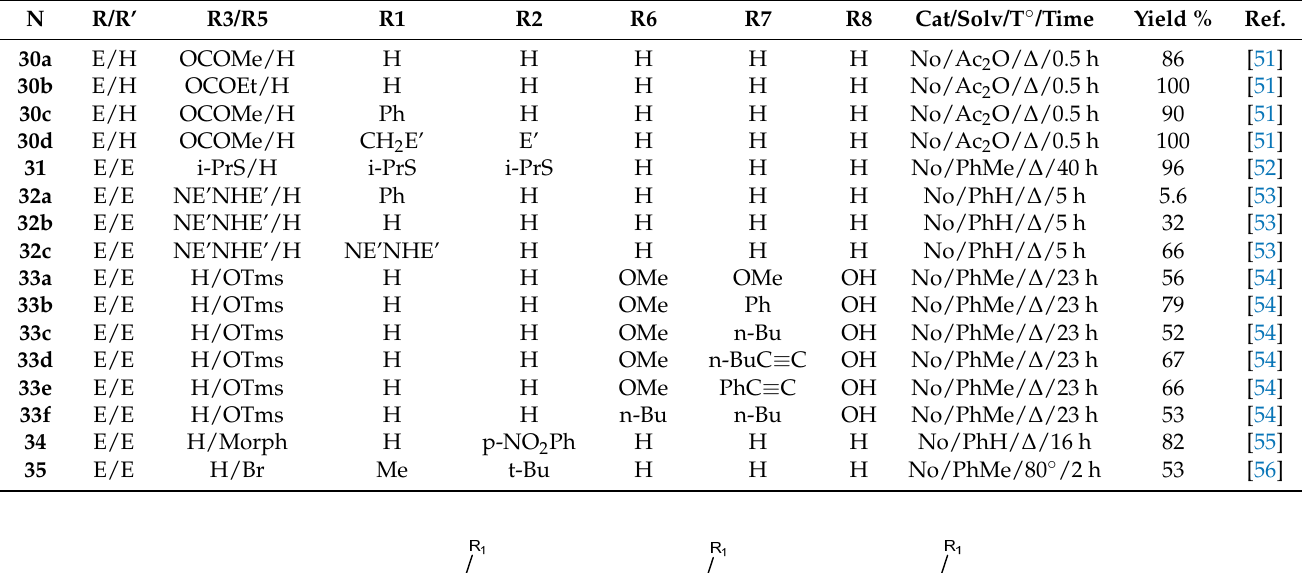
Table 7. Substituents, conditions and yields in cycloaddition of acetylenes to 3(5)-substituted indolizines giving cyclazines (Scheme 15).